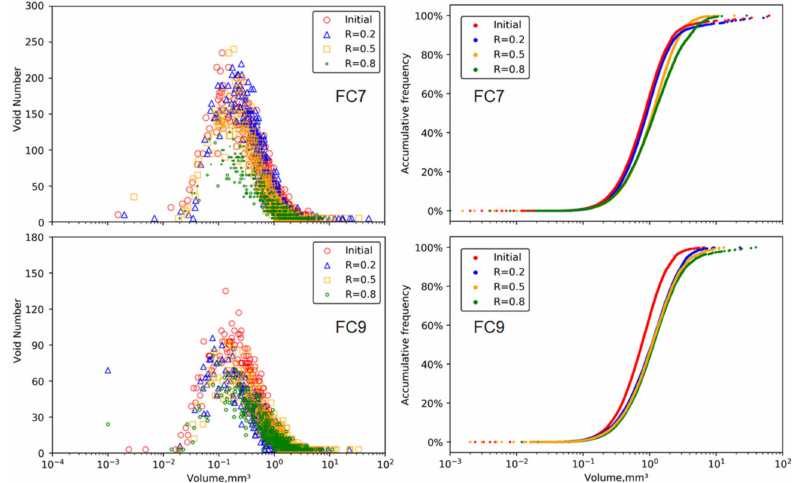
Figure 6. Change of void volume under plane strain quasi-static compression